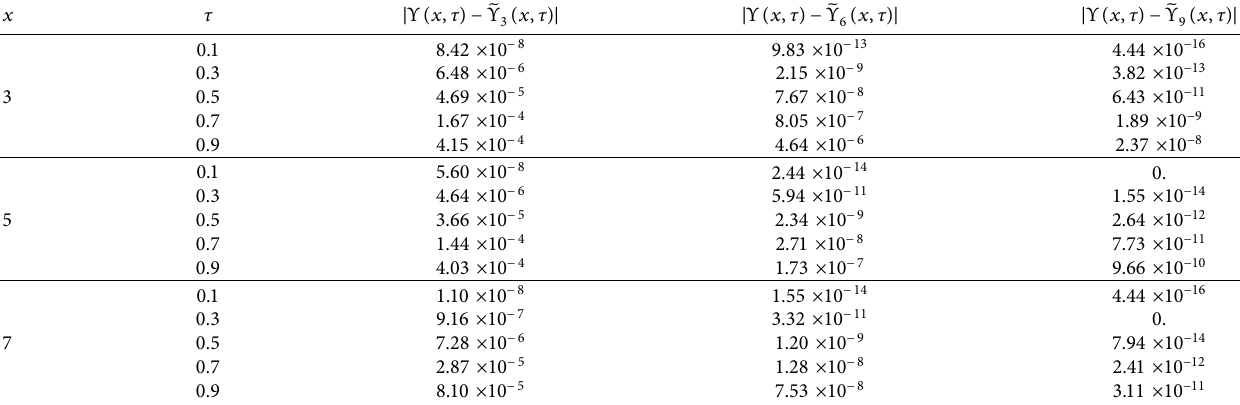
Table 1: Absolute errors at different iterations in Example 1 using He-laplace method when ρ � σ � 1 and ] � 0 . 8.